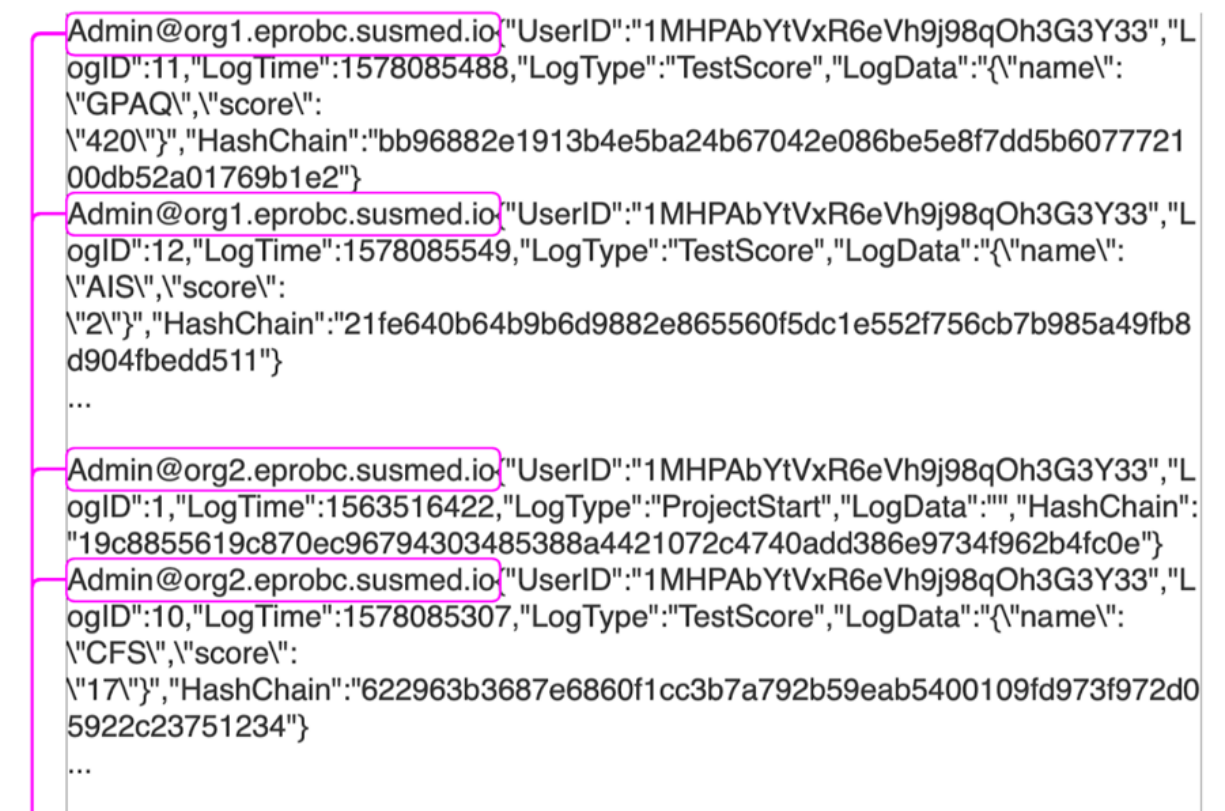
Figure 6. Data verification and validation using records from relay